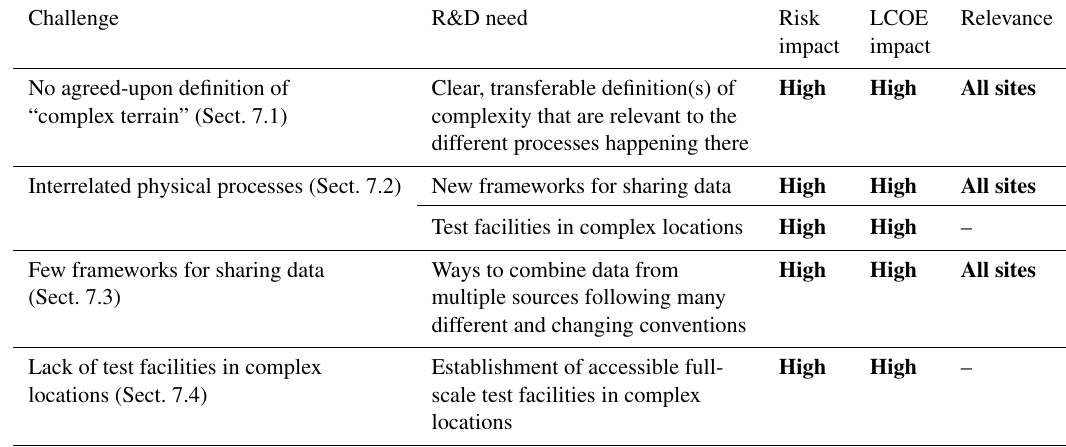
Table 6. General challenges and R&D needs for wind energy plants in complex locations. The table follows the format of Table 1. Challenge R&D need Risk LCOE Relevance impact impact No agreed-upon definition of Clear, transferable definition(s) of High High All sites “complex terrain” (Sect. 7.1) complexity that are relevant to the different processes happening there Interrelated physical processes (Sect. 7.2) New frameworks for sharing data High High All sites Test facilities in complex locations High High – Few frameworks for sharing data Ways to combine data from High High All sites (Sect. 7.3) multiple sources following many different and changing conventions Lack of test facilities in complex Establishment of accessible full- locations (Sect.